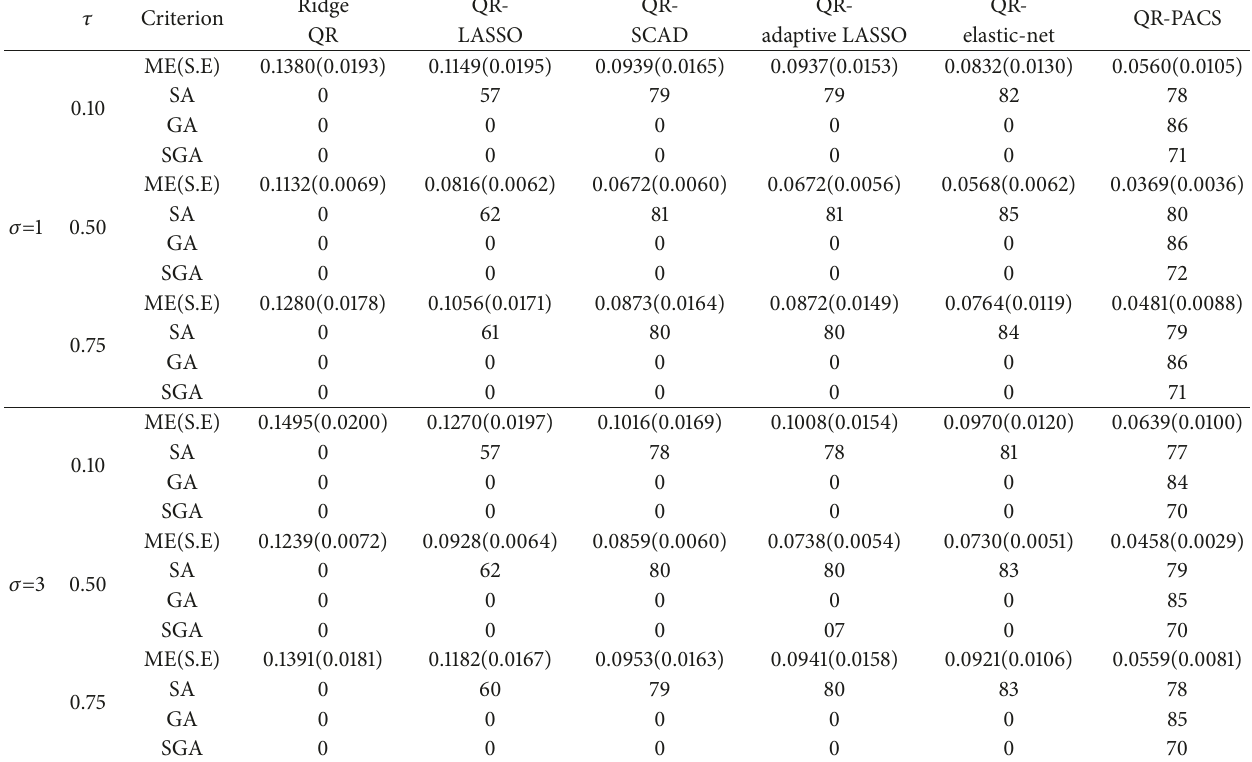
Table 4: ME, SA, GA, and SGA results of Example 4 for